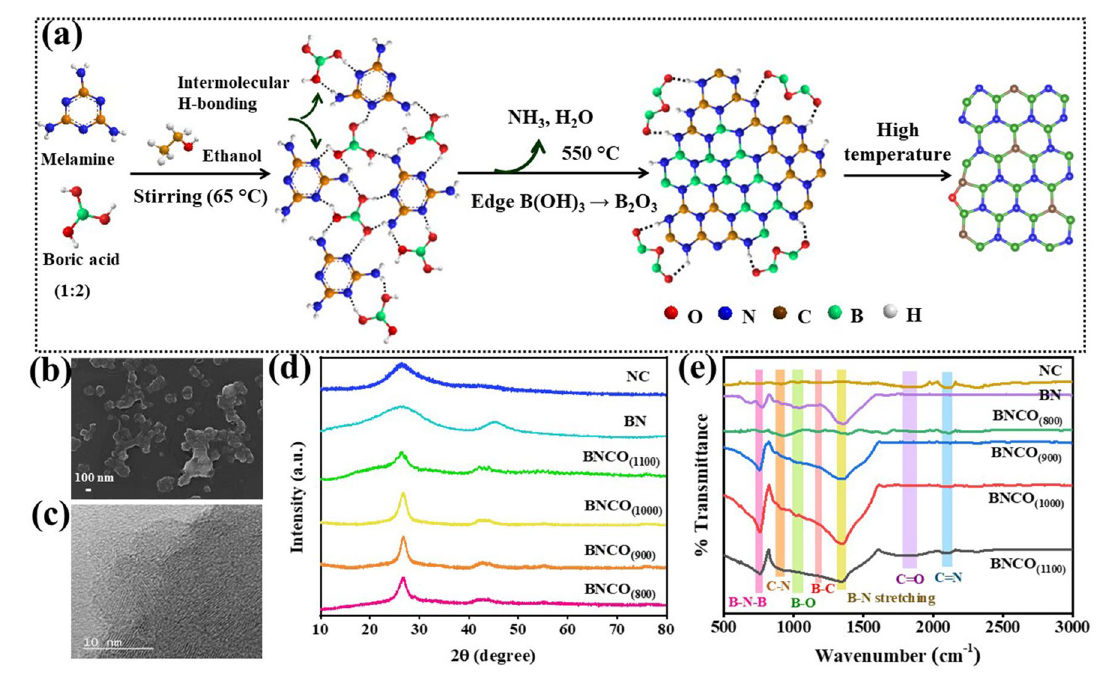
Fig. 2 a Schematic representation of the probable mechanism of BNCO (1000) catalyst synthesis by pyrolysis method. b FESEM image of BNCO (1000) catalyst (scale-bar: 100 nm). c High resolution TEM image of BNCO (1000) catalyst (scale bar: 10 nm). d XRD of all the synthesized catalysts. e FTIR spectra of all the as-synthesized